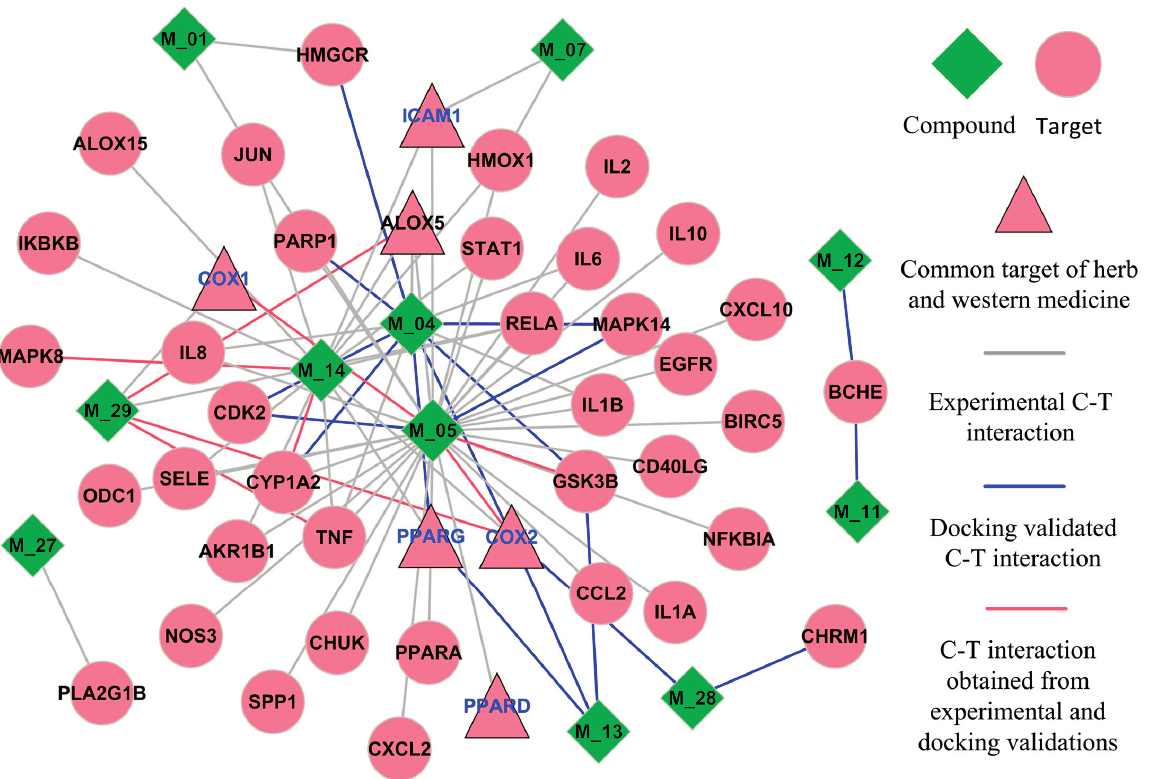
Figure 3. I-T network for Folium Eriobotryae